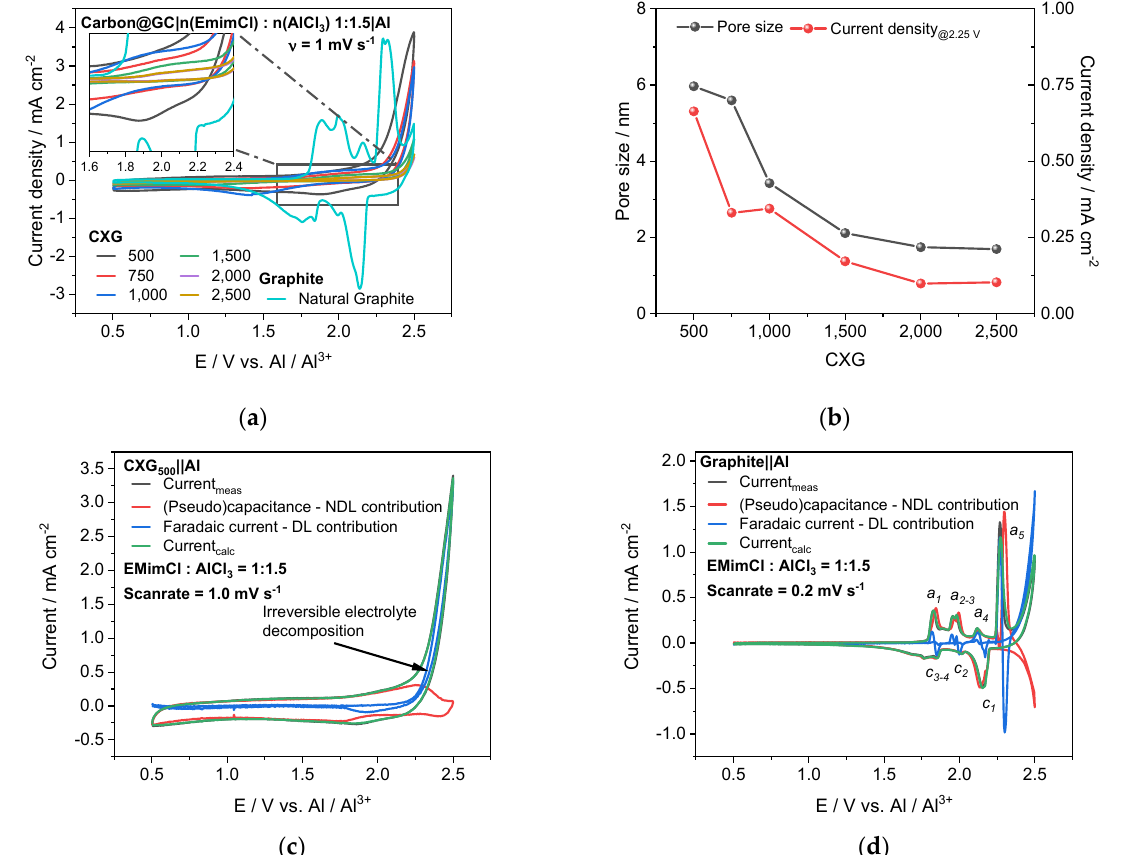
Figure 7. CVs of selected CXGs and natural graphite in 1:1.5 n(EmimCl): n(AlCl3) electrolyte ( a ) and influence of average pore size on max. current density taken from CVs of selected CXG at 2.25V ( b ). Deconvoluted current contribution of non-diffusion limited (pseudo)capacitance and diffusion-limited Faradaic currents in CXG 500 ||Al ( c ) and in graphite||Al ( d ). “(pseudo)capacitance” designation comprises both EDLC and pseudocapacitance contribution.